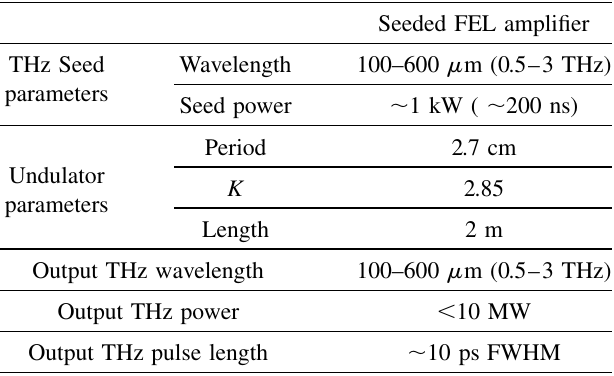
TABLE II. Parameters of the seeded THz FEL amplifier. Seeded FEL amplifier